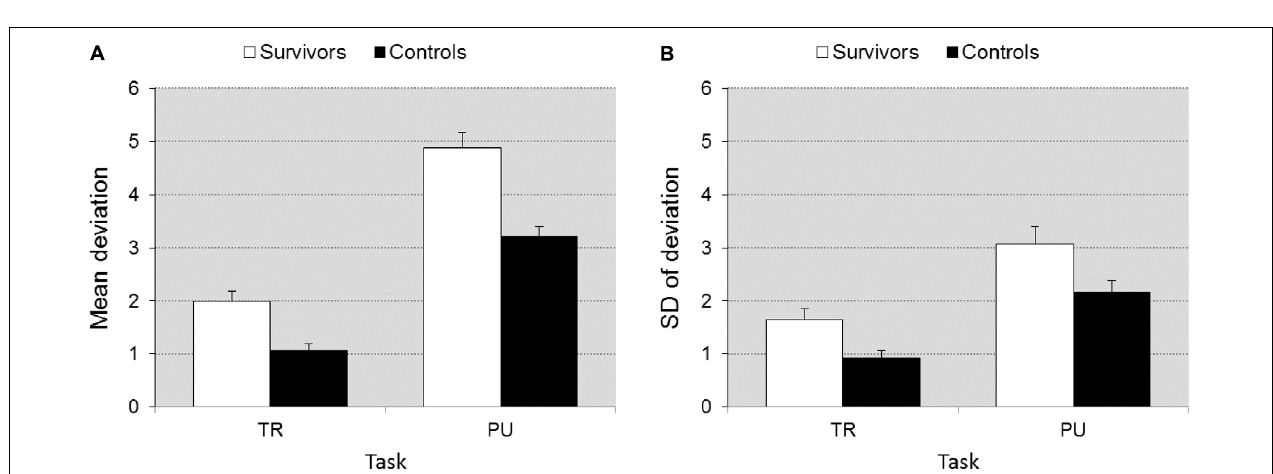
FIGURE 1 | Reaction time ± SEM as a function of memory load (A) and distraction (B) in task MSL. Illustrates the significant group × memory load/distraction interaction. The impact of the increase in memory load/distraction is larger in the survivors.